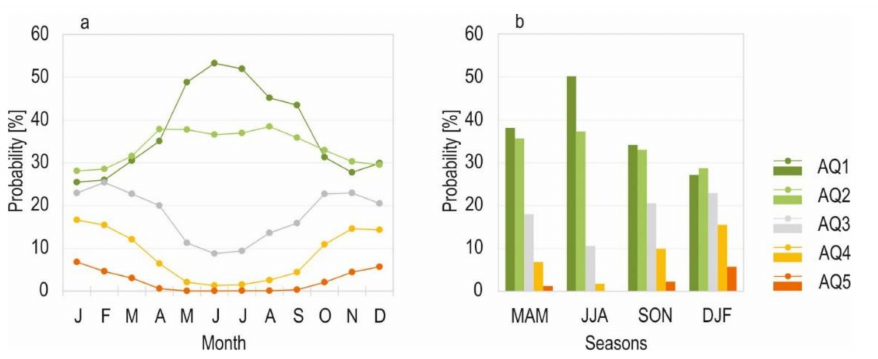
Figure 7. Monthly ( a ) and seasonal ( b ) probability of air quality classes (AQ see Section 2.2) in Silesia. The AQ recognised based on hourly PM 10 data. Average probability for Silesia calculated as arithmetical average from station